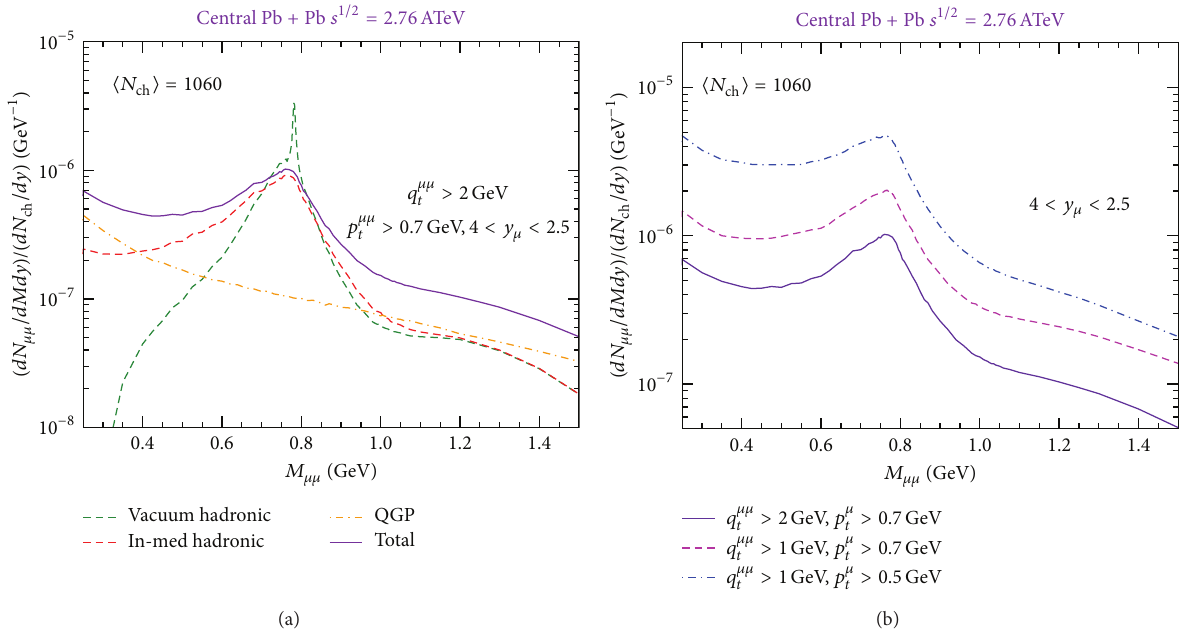
Figure 13: Calculations of thermal dimuon invariant-mass spectra in central Pb-Pb(2.76ATeV) collisions at forward rapidity, 𝑦 = 2.5 – 4 . (a) in-medium hadronic, vacuum hadronic, QGP and the sum of in-medium hadronic plus QGP, are shown with “strong” cuts on single and dimuon transverse momenta. Part (b) illustrates how the total yield increases when the two cuts are relaxed.